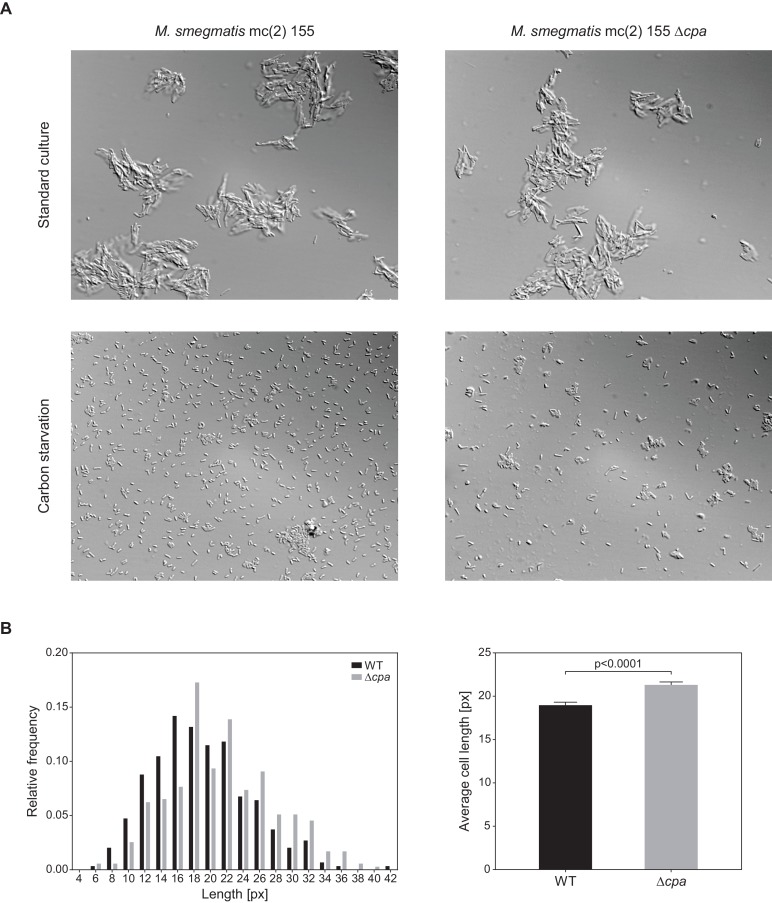
M. smegmatis cells lacking cpa do not exhibit significant differences in size or shape to wild-type cells either under standard conditions or when grown in absence of glycerol.(A) Light microscopy images of M. smegmatis wild-type and ∆cpa cells during growth in presence (top) and absence (bottom) of glycerol as a main carbon source. (B) Statistical analysis of the average cell length during carbon starvation. A histogram depicting the distribution of cell length (in pixels) is shown on the left and the average cell length for both strains is shown on the right. The error bars represent standard error of the mean (SEM). The cell length difference is statistically significant at the p-value of 0.0001 (unpaired two-tailed t-test).